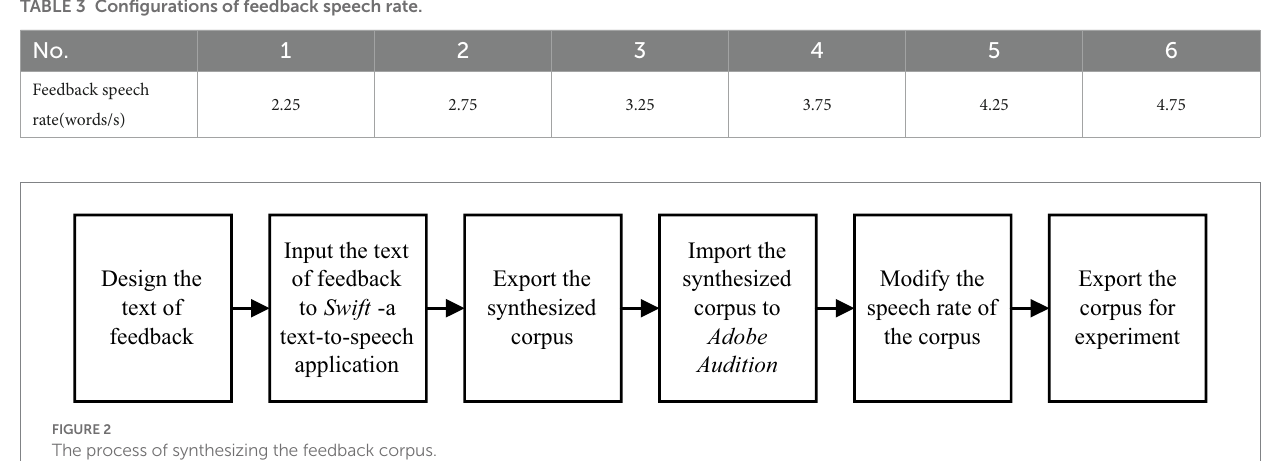
TABLE 3 Configurations of feedback speech rate.